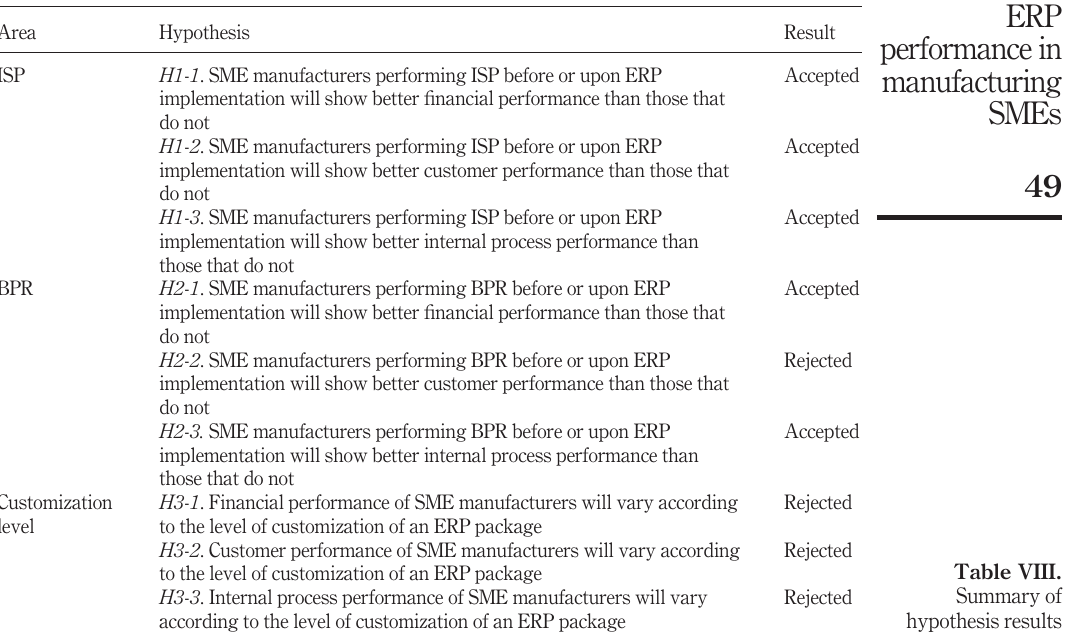
Table VIII. Summary